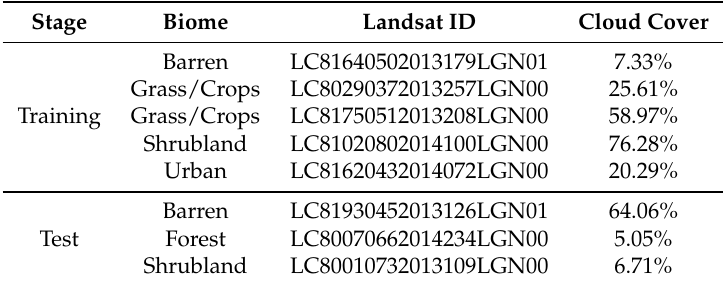
Table A2. Landsat ID and Cloud Cover of the 8 images used in Section